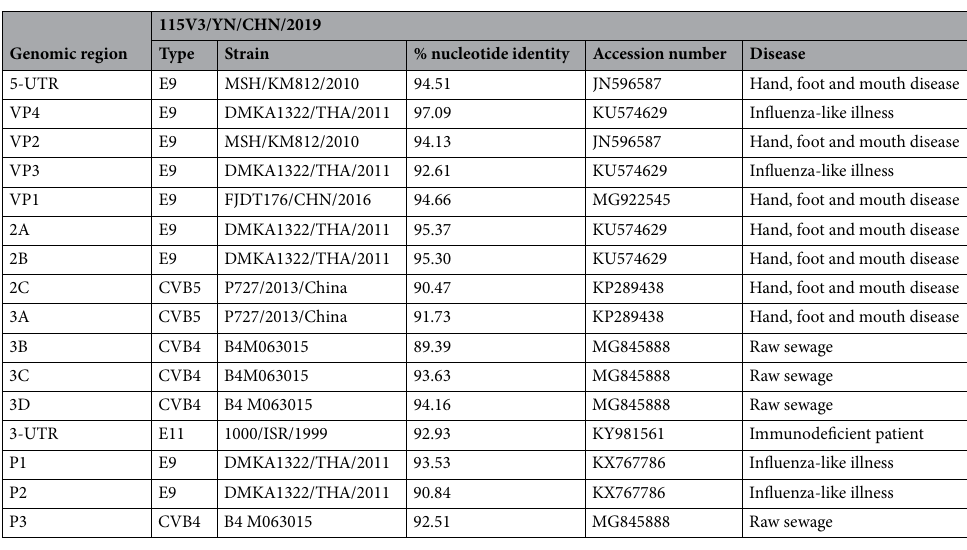
Table 3. Highest similarity of nucleotide sequences of enteroviruses in all sequenced genomic regions of the 115V3/YN/CHN/2019 strain, determined with BLAST